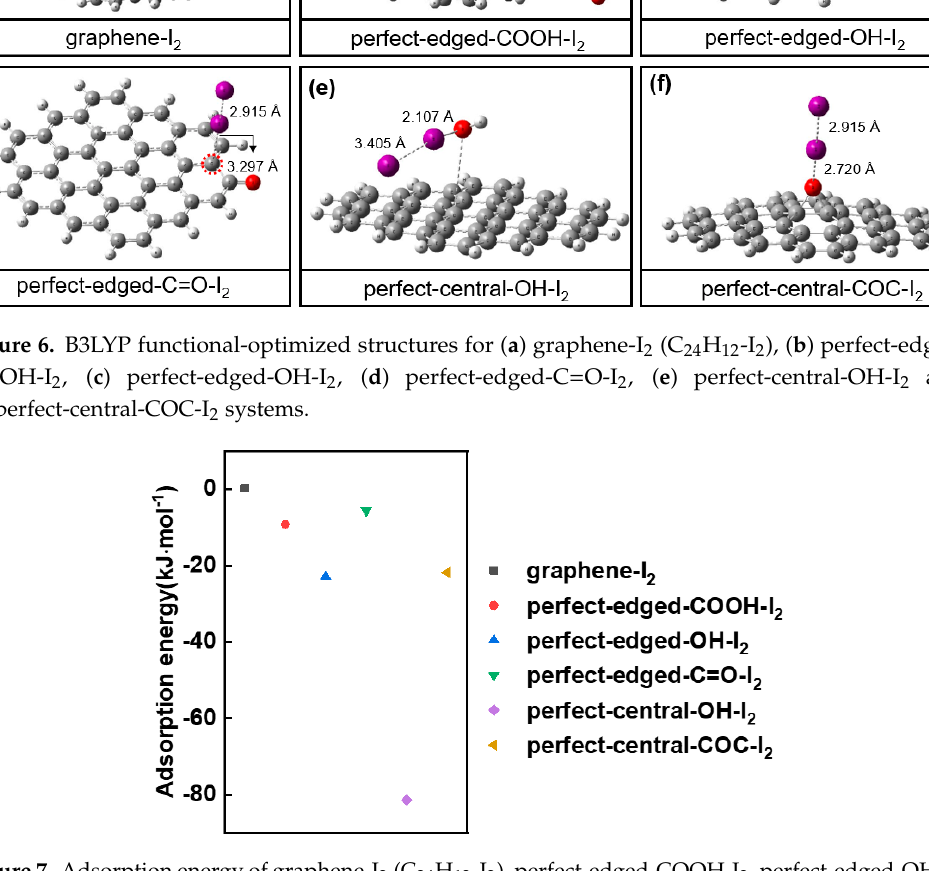
Figure 7. Adsorption energy of graphene-I 2 (C 24 H 12 -I 2 ), perfect-edged-COOH-I 2 , perfect-edged-OH-I 2 , perfect-edged-C=O-I 2 , perfect-central-OH-I 2 and perfect-central-COC-I 2 systems.